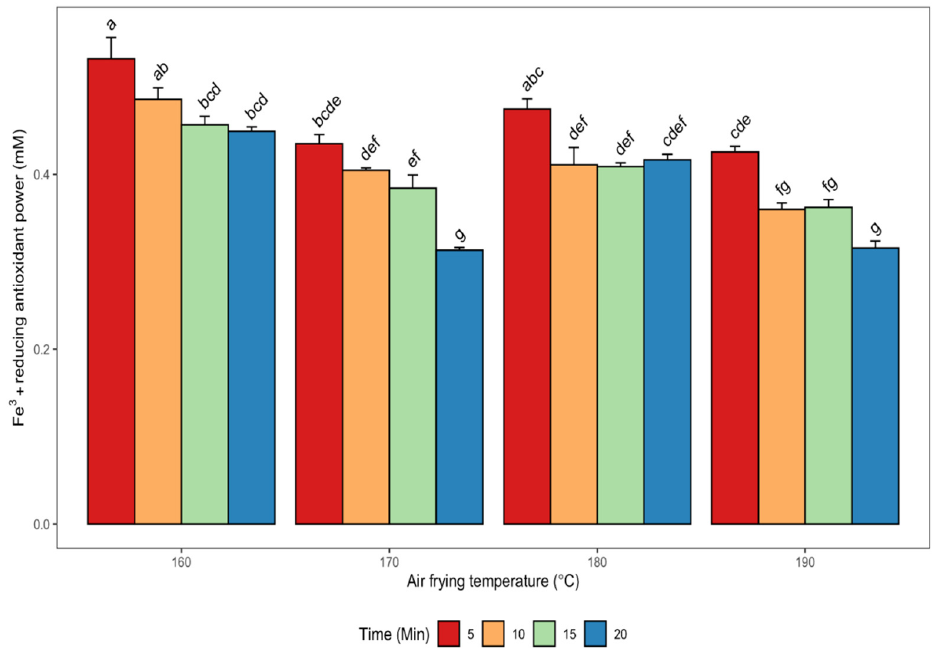
Figure 4. Changes in ferric reducing antioxidant power (FRAP) of de-oiled canola meal extracts as affected by different air frying conditions. Error bars indicate the SD of the measurements for each sample ( n = 3). Bars with different letters (a–g) have significantly ( p < 0.05) different mean values.